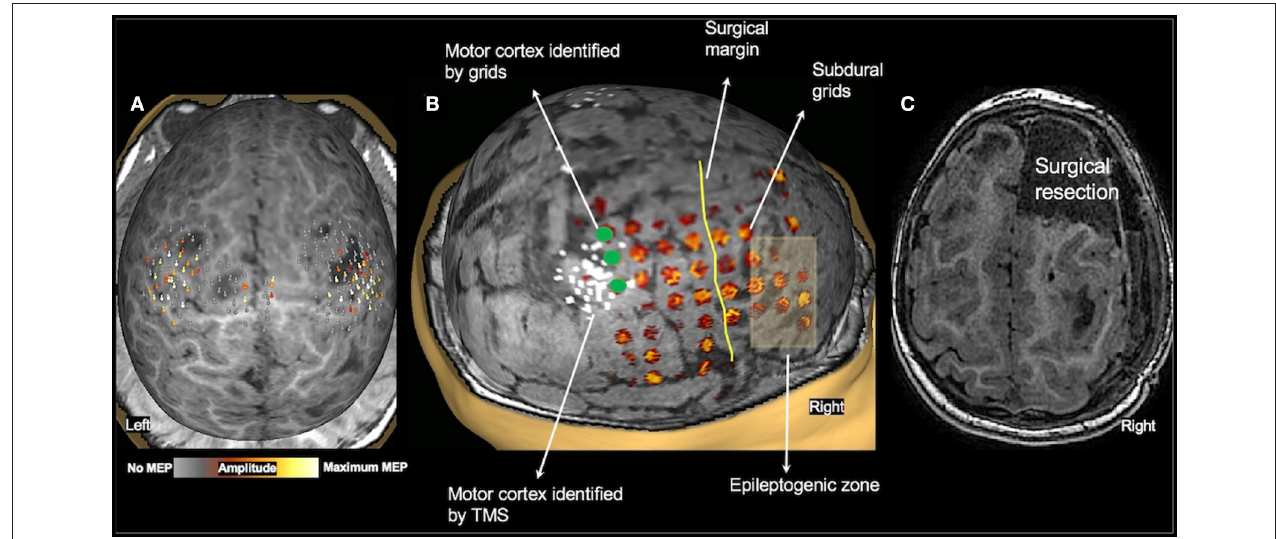
FIGURE 5 | Validation of TMS motor mapping by CSM. Presurgical TMS-derived motor mapping in a 2.3-year-old female with tuberous sclerosis complex type 2. (A) : TMS localized motor cortex in the right hemisphere in the precentral gyrus in the vicinity of a tuber. (B) : The child underwent subdural grid placement, and the epileptogenic focus was localized to be anterior to the motor cortex. (C) : The child underwent right anterior frontal lobectomy including the epileptogenic focus. Post-operatively, the child moves all extremities equally with normal bulk and strength and uses either hand to reach for an